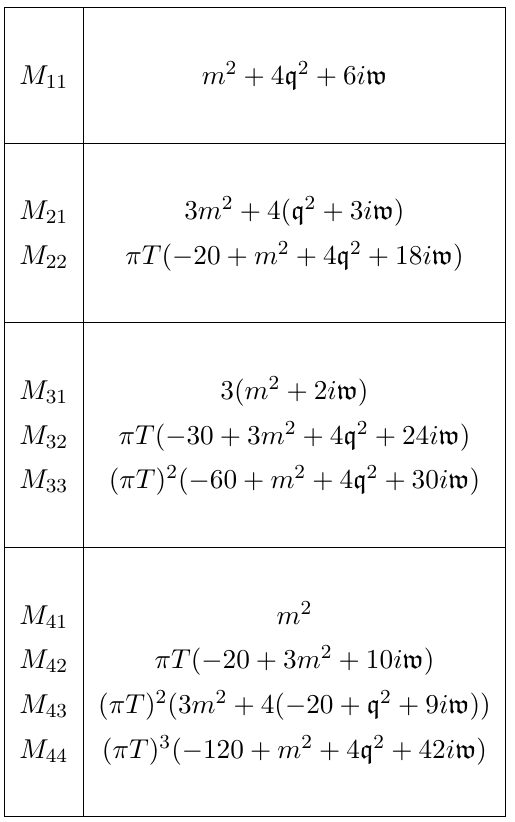
Table 1 . Examples of coefficients for the equations of motion for the scalar bulk field expanded near the